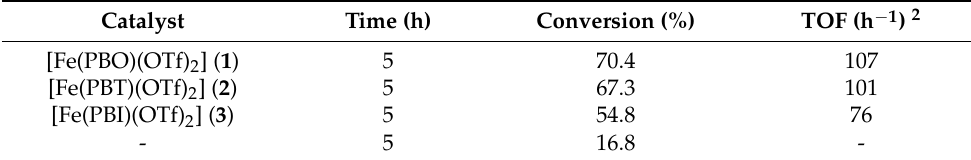
Table 5. Dependence between the conversion and number of turnover values on the catalyst ( 2 ) and mCPBA concentrations for the iron(II)-catalyzed Baeyer–Villiger oxidation of cyclohexanone by mCPBA 1 .